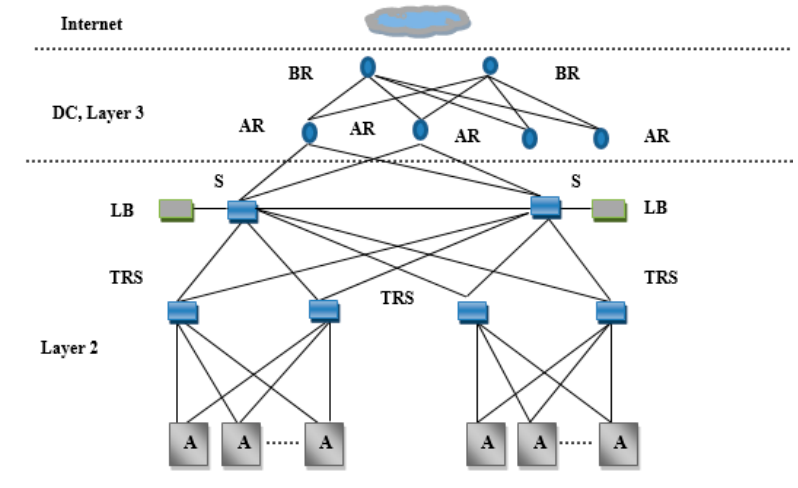
Figure 1. Conventional data center (DC) architecture.